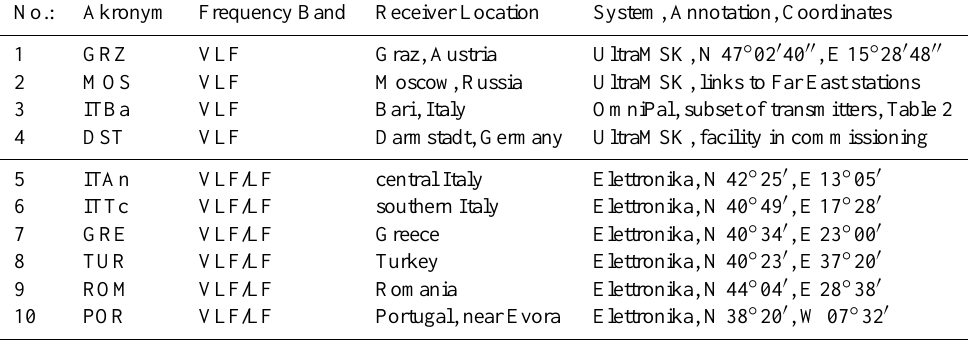
Table 1. Core network VLF/LF receiving stations by type (UltraMSK, 2010) and (Elettronika, 2010) and their spatial distribution. The International Network for Frontier Research on Earthquake Precursors (INFREP, 2010) in Bari, Italy, is a central node for data access. No.: